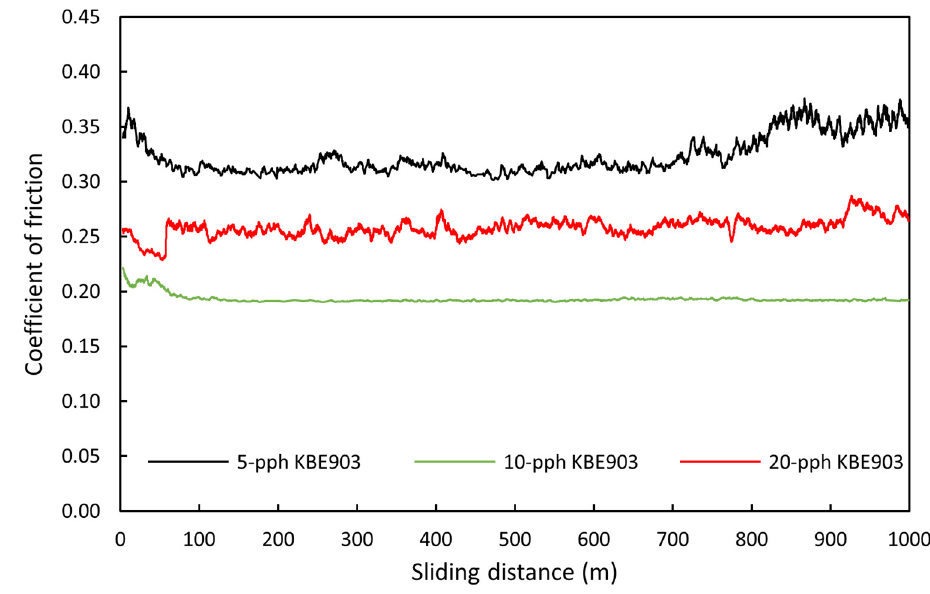
Figure 7. Coefficient of friction with respect to sliding distance of treated Sm 2 O 3 /UHMWPE compo- sites with varying silane contents of 5, 10, and 20 pph and Sm 2 O 3 content of 25 wt.%.